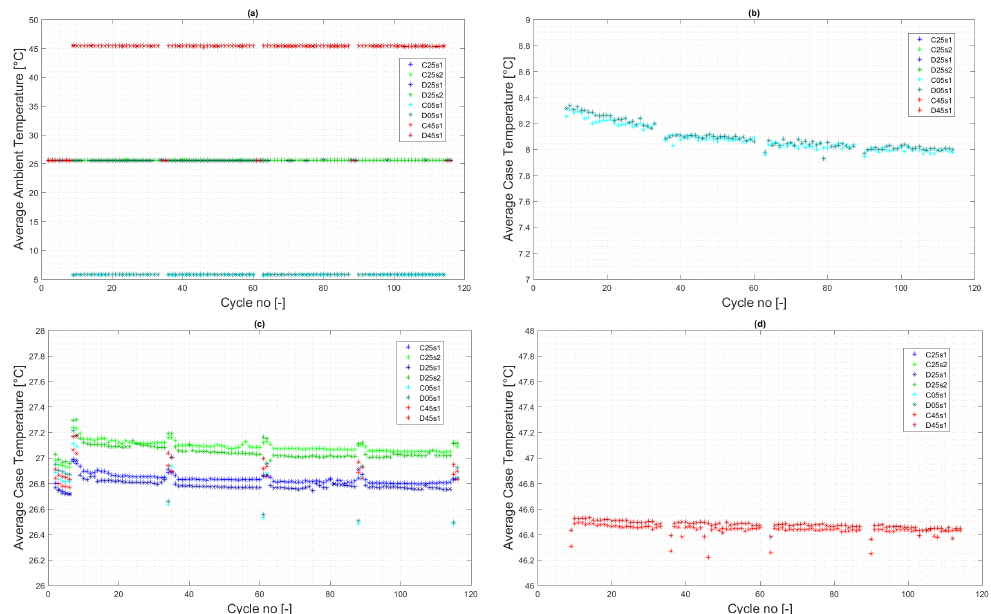
Figure 10. Measured values of average ambient ( a ) and case temperature zoomed to the three relevant ranges of set temperature 5 ◦ C ( b ), 25 ◦ C ( c ) and 45 ◦ C ( d ) for all the measured cycles and samples.